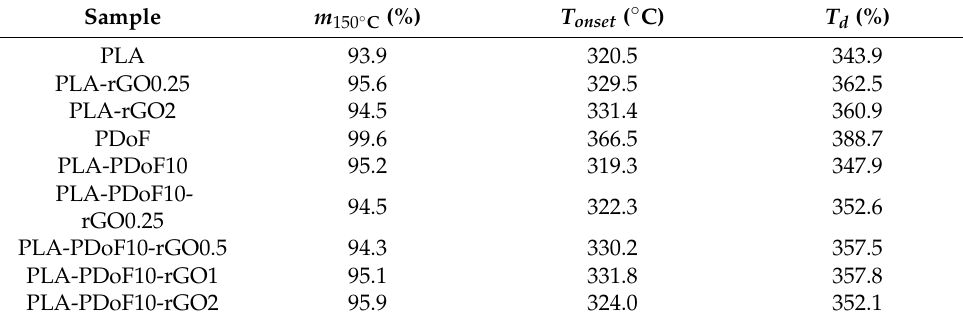
Figure 5. Residual mass ( a ) and mass loss derivative ( b ) as a function of temperature from TGA tests on the prepared films. Only some selected compositions are reported for clarity. Table 1. Main results of the TGA tests on the prepared samples.